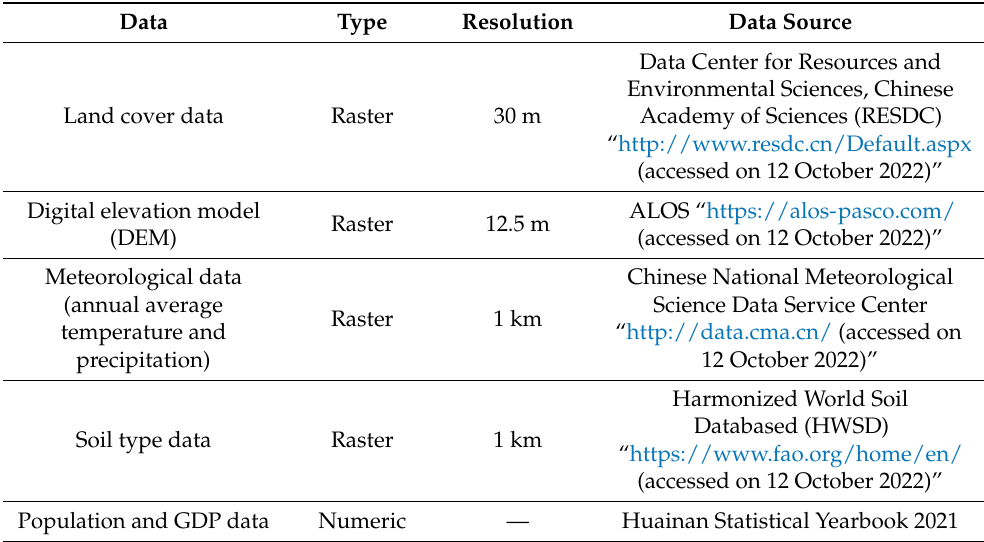
Table 1. Data descriptions and sources used in this